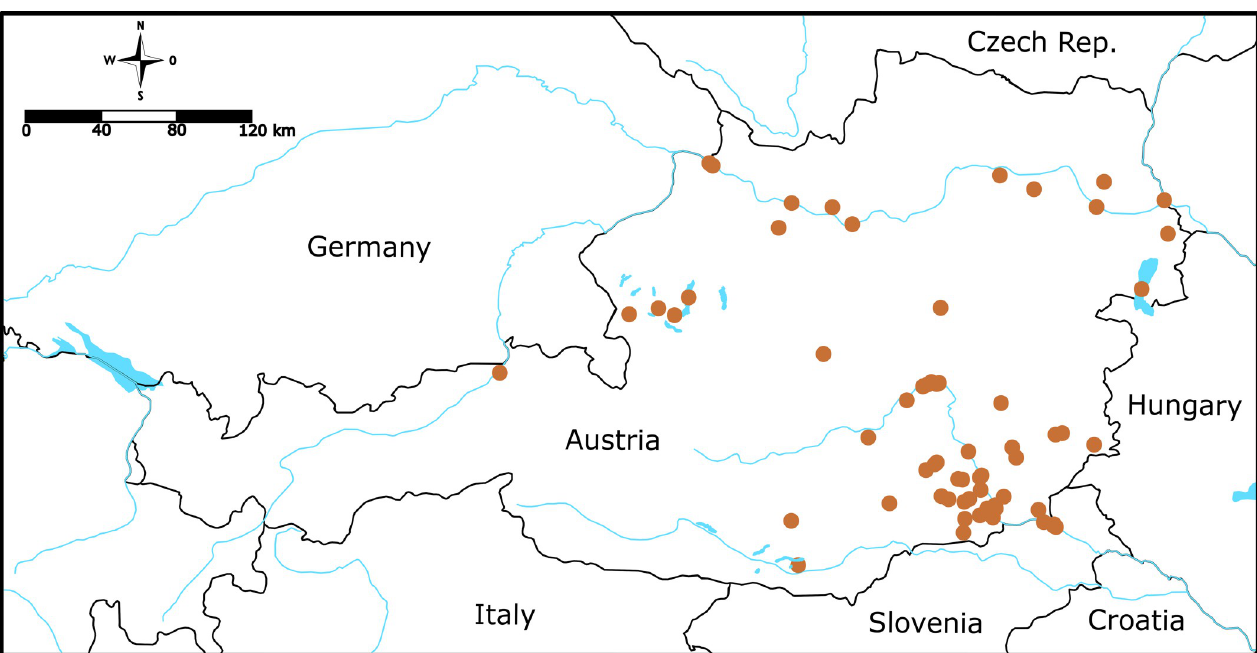
Fig 1. Map of sampling localities. Map of Austria and surrounding countries indicating the sampling locations of newly sequenced samples (orange spheres).